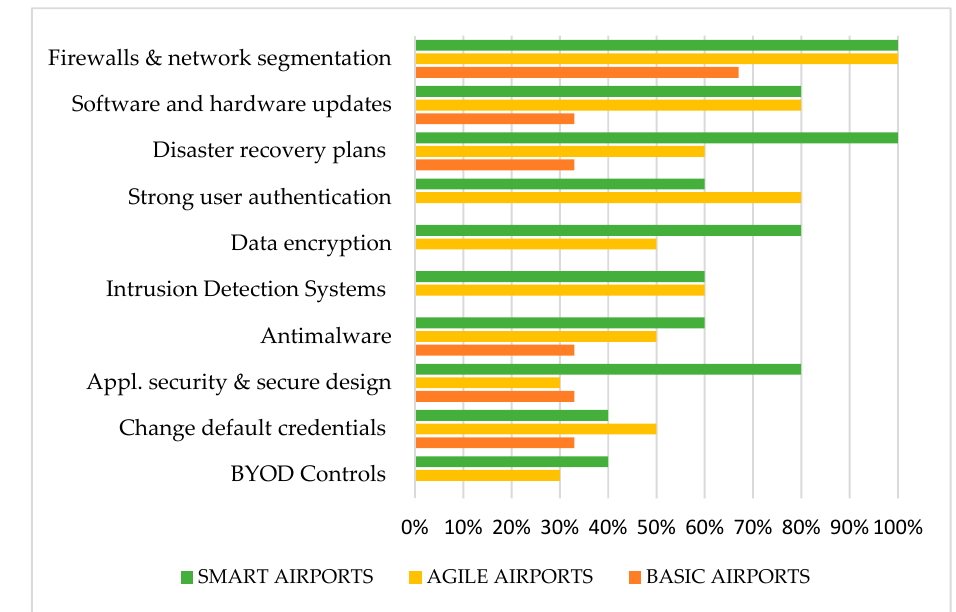
Figure 3. Technical good practices implementation analysis.